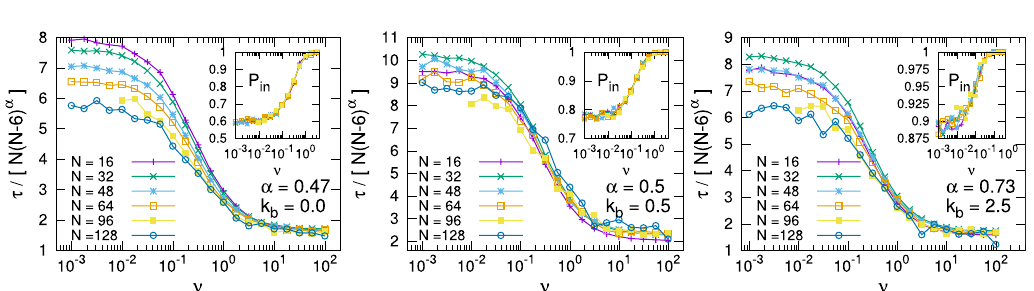
Figure 7. τ at different N values. Each panel corresponds to a different k b and shows three rate values: ν 1 = 10 − 2 (upper curves), ν 2 = 1 (middle curves), ν 3 = 10 2 (lower curves). The full lines stand for τ = bN ( N − 6) α with b the unique fit parameter.